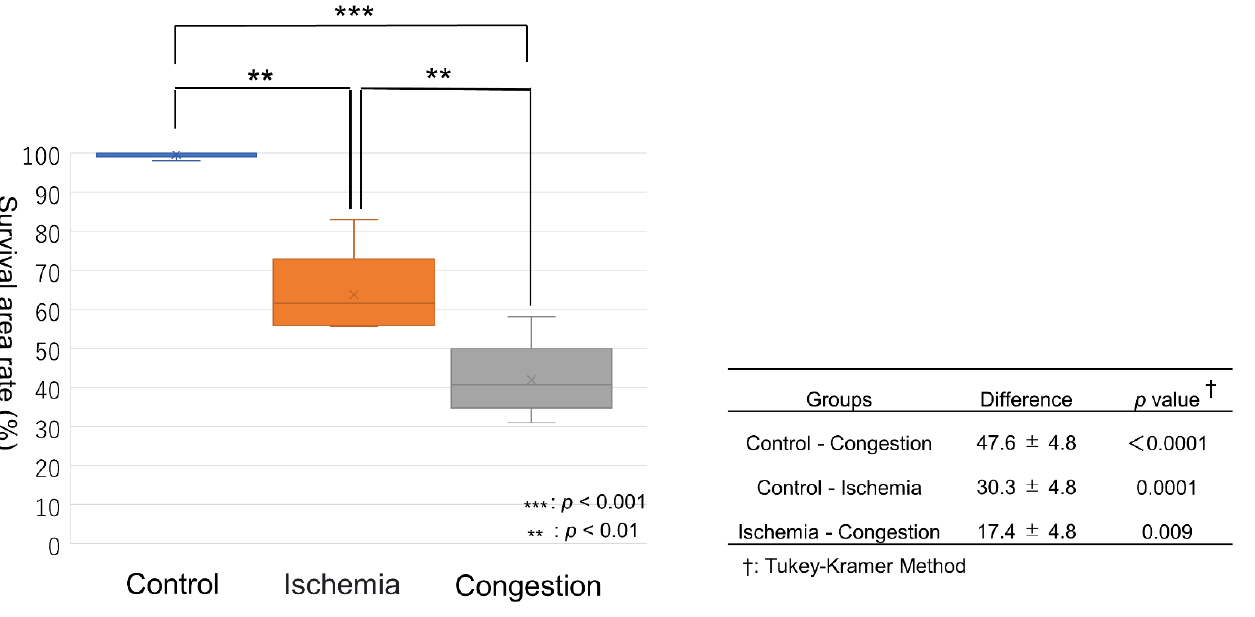
Figure 5. A difference in surviving skin paddle area rates was found between the control, ischemic, and congestive flaps.